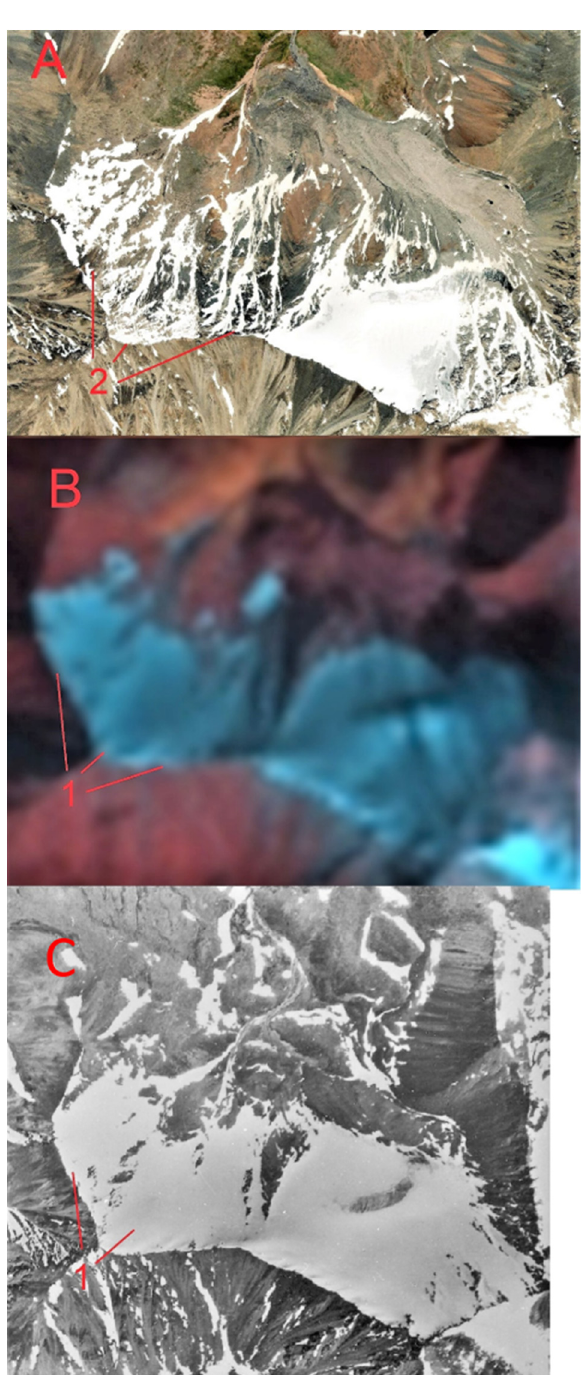
Figure 5. Degradation of hanging glaciers, Mongun Taiga massif. ( A ) WorldView-2 image, 26 June 2015, ( B ) Landsat 5 image, 5,4,3-bands combination, 15 September 1987, ( C ) aerial image, 10 July 1966: 1—Degrading small hanging glaciers, 2—Nival niches in place of degraded